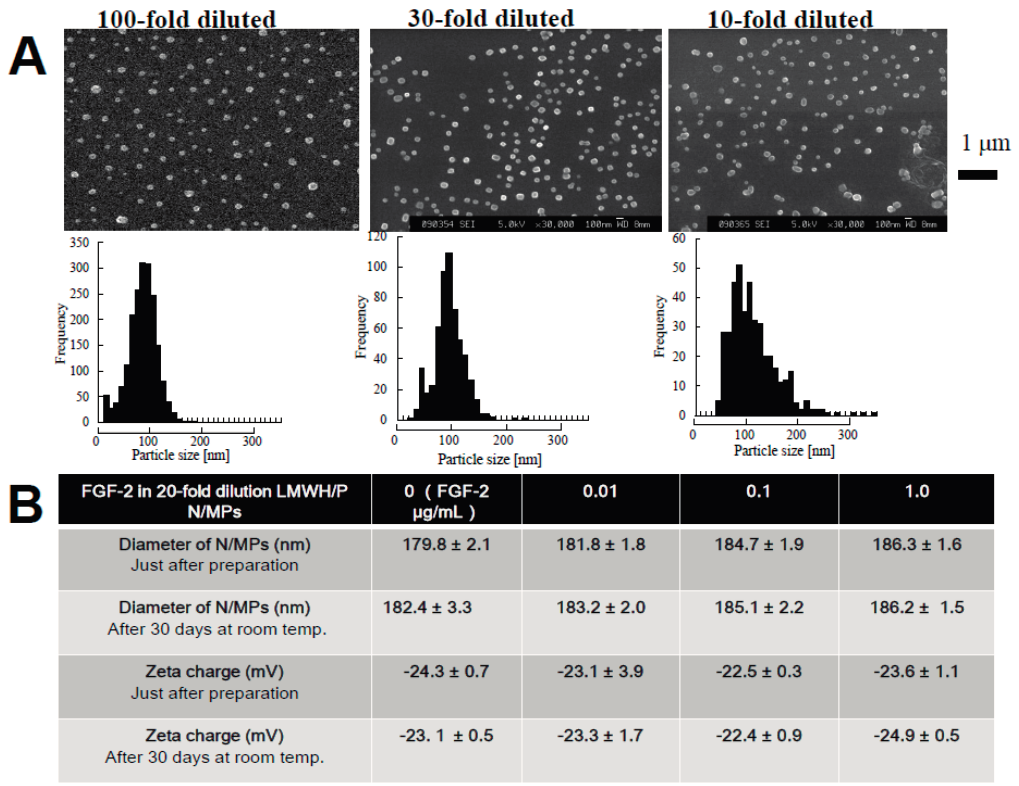
Figure 2. ( A ) Distribution of diameter of LMWH/P N/MPs; ( B ) Characterization of LMWH/P N/MPs and their stabilities. Stabilities of fibroblast growth factor (FGF)-2 and LMWH/P N/MPs were examined by measuring diameters of N/MPs and their zeta-electric